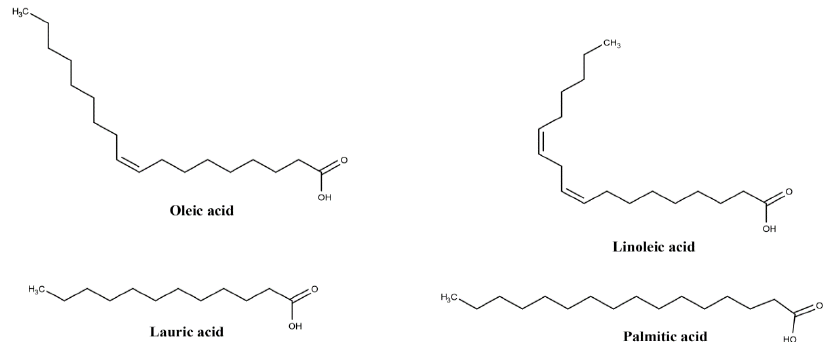
Figure 2. Structures of the main fatty acids in Euterpe oleracea Mart. oil.